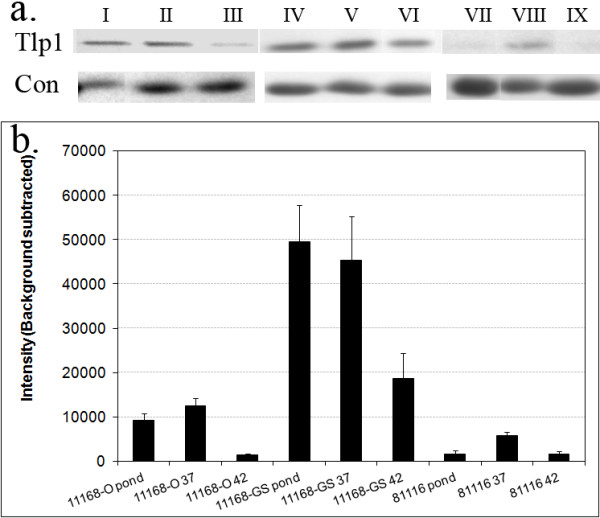
Quantitative protein analysis of cellular Tlp1 levels. a.) Representative blot result from a Western blot performed using anti-Tlp1 sera. Samples are as follows for Tlp1 and Con; I). C. jejuni 11168-O maintained at room temperature in pond water; II). grown at 37°C; III). grown at 42°C. IV). C. jejuni 11168-GS maintained at room temperature in pond water; V). grown at 37°C; VI). grown at 42°C. VII). C. jejuni 81116 maintained at room temperature in pond water; VIII). grown at 37°C; IX). grown at 42°C. A single band was observed at ~75 kDa corresponding to the predicted size of Tlp1. The loading control shows the band (~30 kDa) that was used to ensure the same amount of protein was loaded in each well. b.) Quantitative densitometry analysis of Tlp1 protein detected by anti-Tlp1 sera. Average background subtracted band intensity was determined using QuantityOne software (Bio-Rad) from triplicate repeat anti-Tlp1 Western blots of C. jejuni 11168-O, 11168-GS and 81116 maintained at room temperature in pond water; grown at 37°C; grown at 42°C. Errors bars equal to 3x standard error of the mean (SEM).